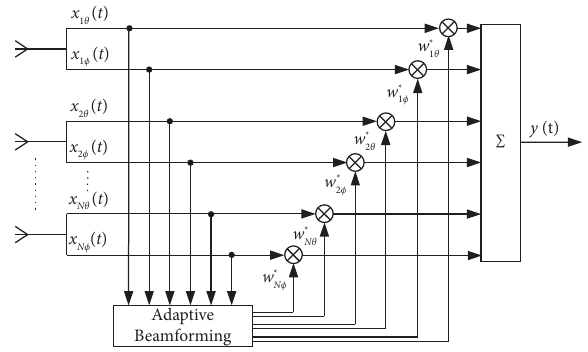
Figure 1: Schematic diagram of a dual-polarized array beamformer where (·) ∗ is conjugate